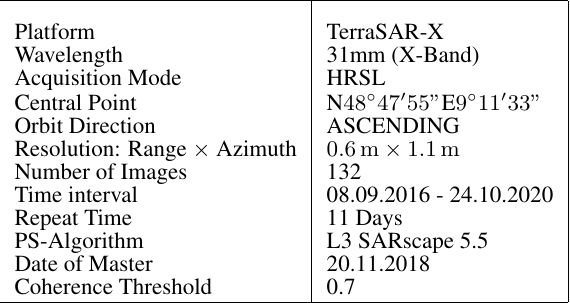
Table 1. SAR Data acquisition and processing